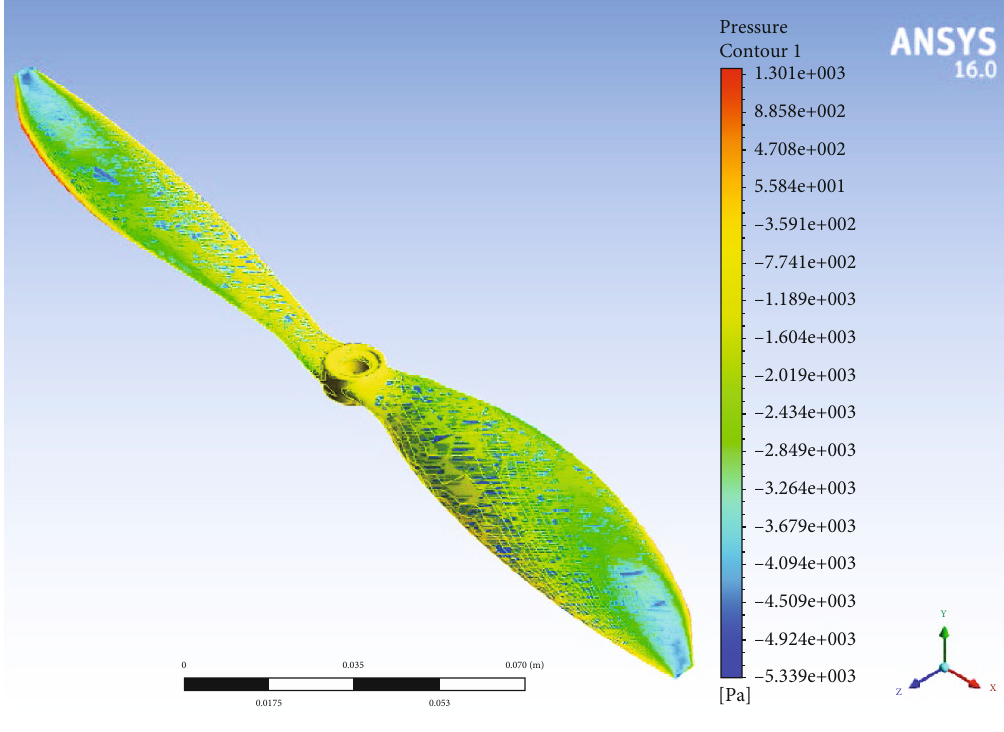
Figure 23: Pressure contour at -100 ° C